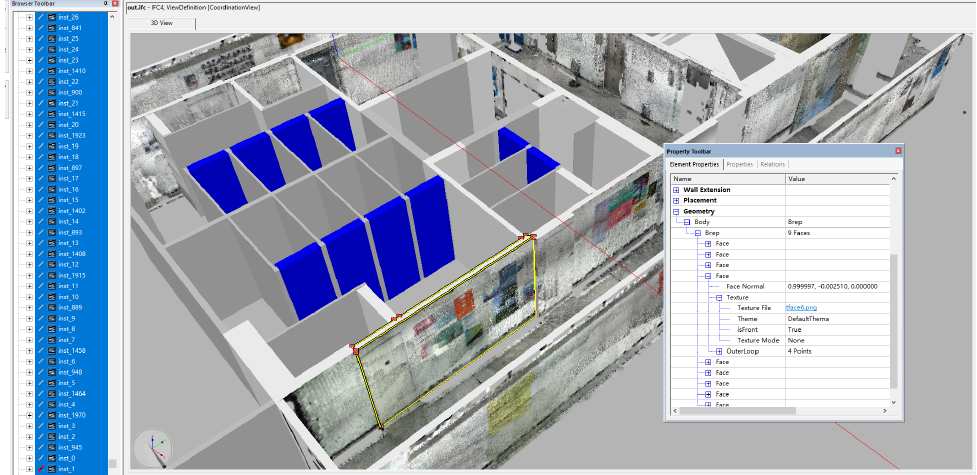
Figure 8. Example DTB textured by the registered point